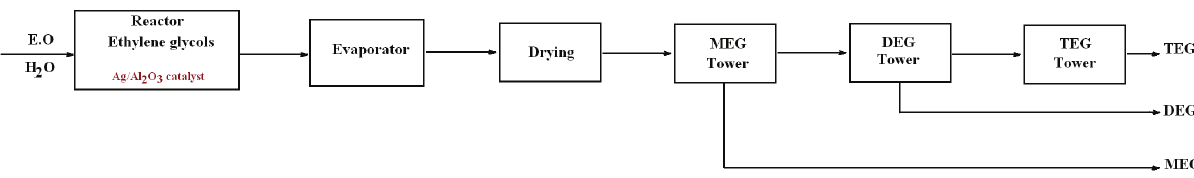
Figure 2: Production charts of ethylene glycol